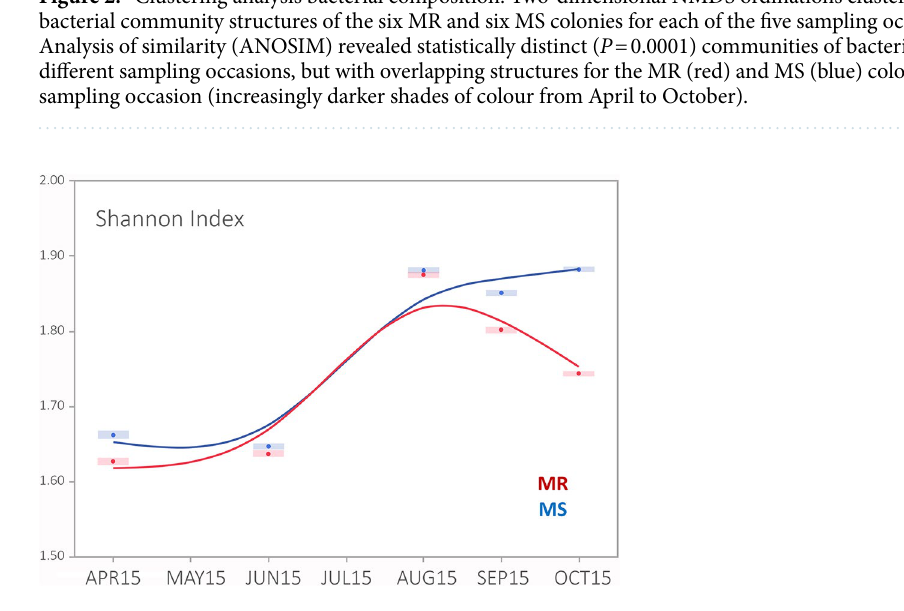
Figure 3. Bacterial community diversity analyses. Shannon H-index estimates for bacterial community diversity in the MR (red) and MS (blue) colonies between April and October 2015. The size of the circles represents the standard deviation for the estimate at the nodes. Similar graphs were obtained with other diversity